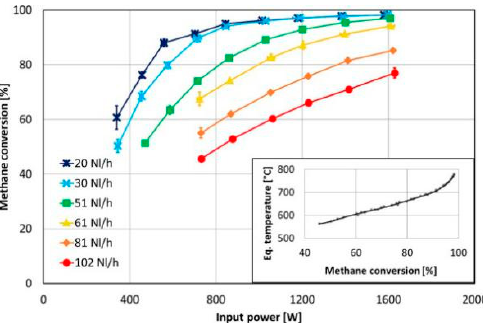
Figure 12. NiCo/MgAl 2 O 4 catalyst methane conversion versus heater power [79].